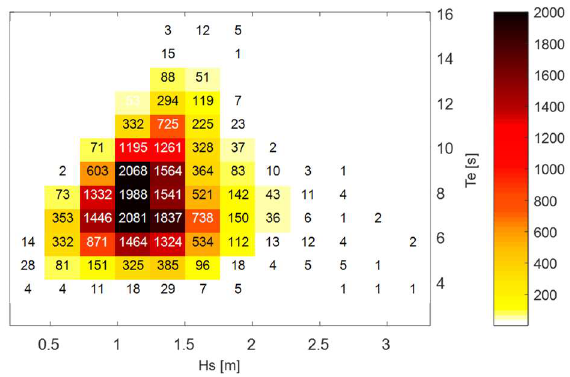
Figure 4. Total probability distribution of sea sates at six-hourly occurrence in Kilifi.